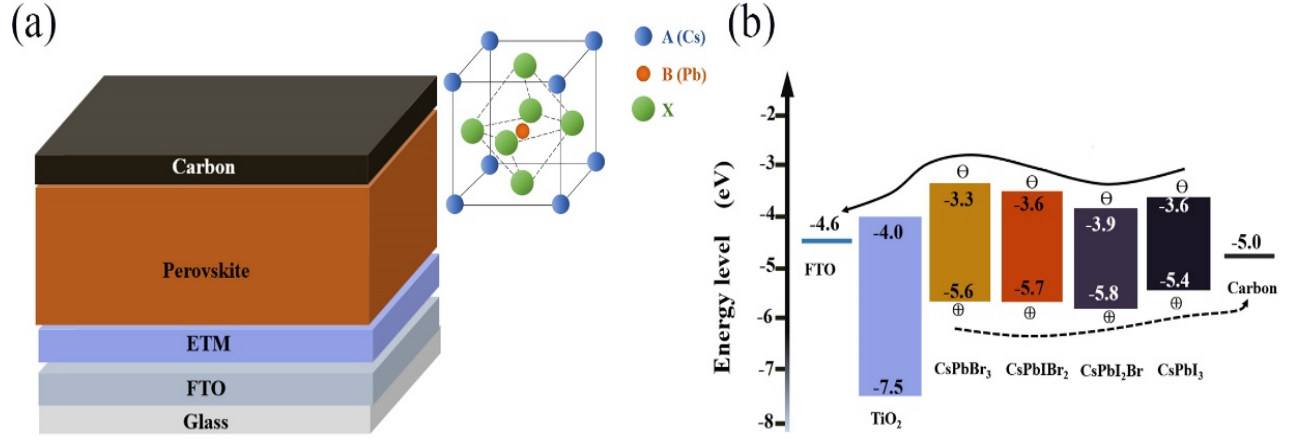
Figure 1. ( a ) The device configuration (inset: crystal structure of perovskite films) and ( b ) the energy level diagram of CsPbBr 3 , CsPbIBr 2 , CsPbI 2 Br, and CsPbI 3 C-IPSCs. The band structures of FTO, TiO2, carbon, and perovskite films are referred to from the previous literature [25,42–44].